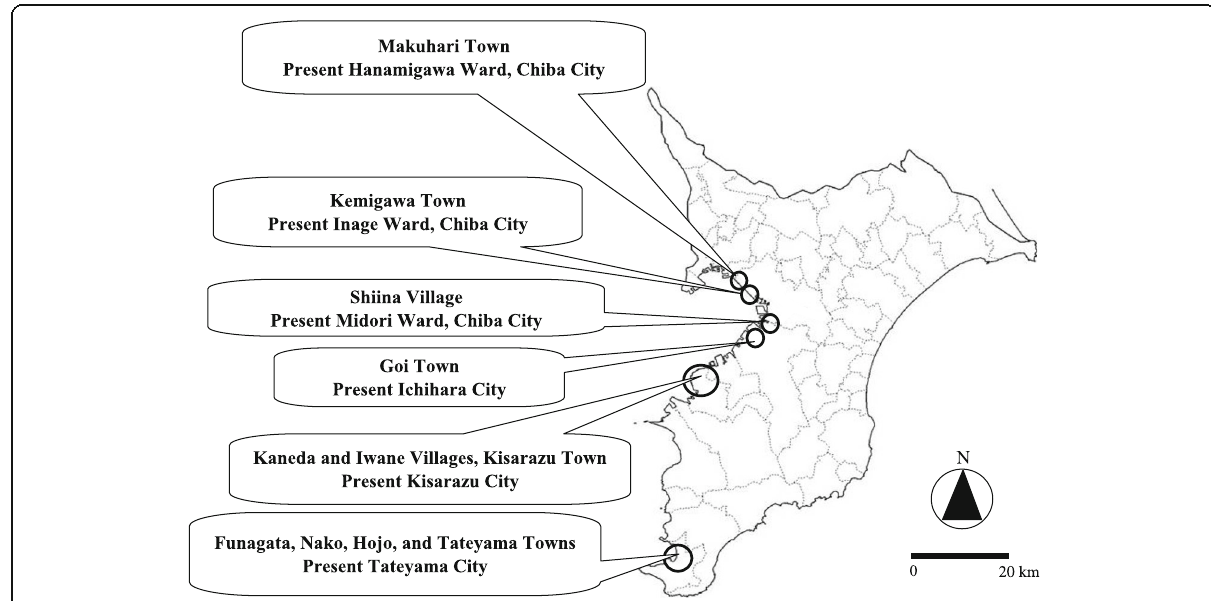
Fig. 4 Coastal region where sake brewing was practiced in 1925. Light gray lines show municipality boundaries in Chiba Prefecture in